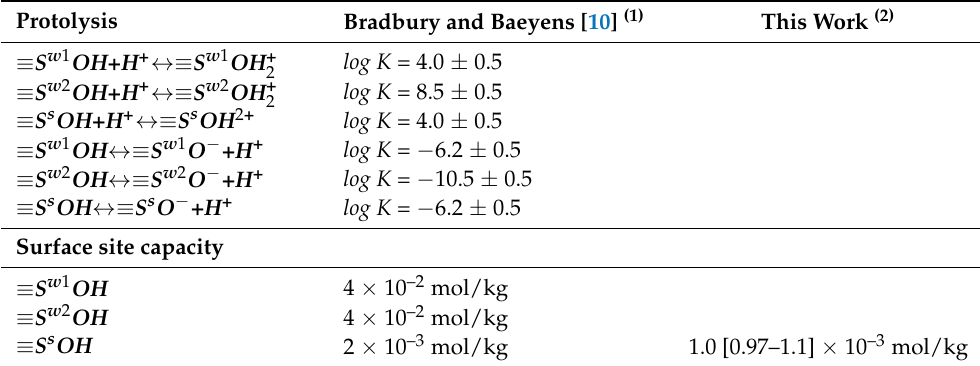
Table 3. Protolysis reactions and constants and surface site capacities for Illite du Puy. Protolysis Bradbury and Baeyens [10] (1) This Work (2)